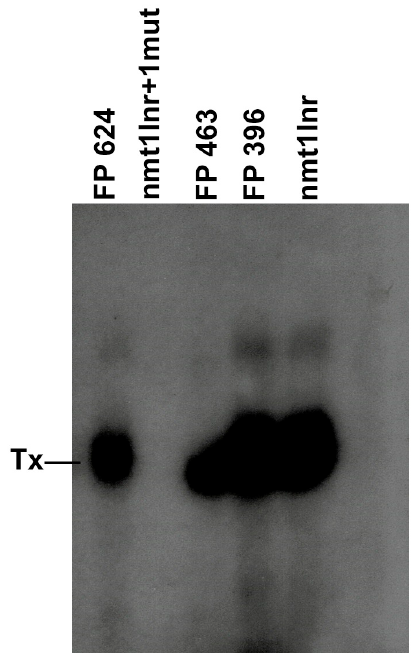
Figure 7. Inr of the hDHFR/nmt1 family can be transcribed in WCE. Three promoters, namely FP000624 (FP 624), FP000463 (FP 463), and FP000396) (FP 396) were cloned (from − 20 to +10), fused to the G-less cassette, transcribed in WCE, and compared with the nmt1 Inr +1 mutant (nmt1Inr + 1mut) and the wild-type nmt1 Inr (nmt1Inr). It can be observed that the three promoters can support transcription initiation in crude extracts. Tx indicates the transcription